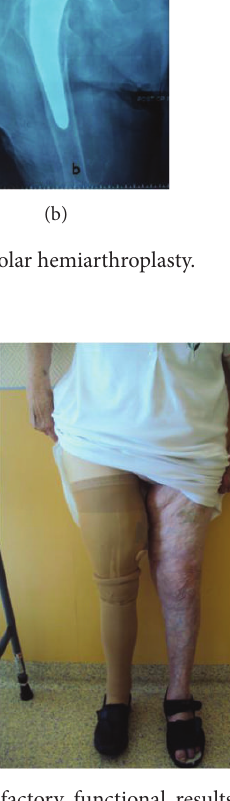
Figure 6: Satisfactory functional results, at the follow-up of 24